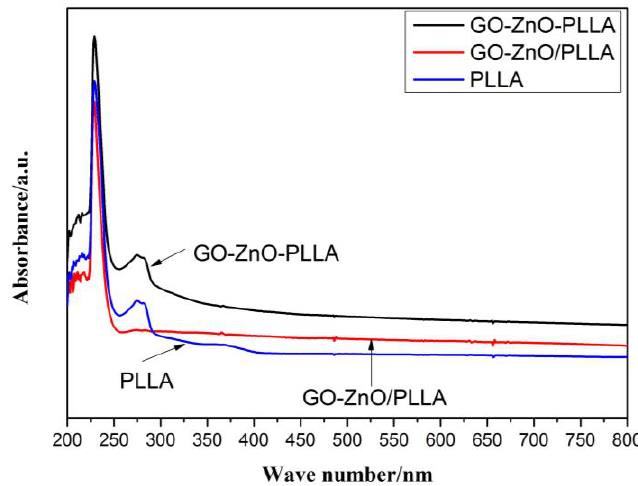
Figure 2 . UV/Vis spectra of PLLA, GO-ZnO-PLLA, and GO-ZnO/PLLA.